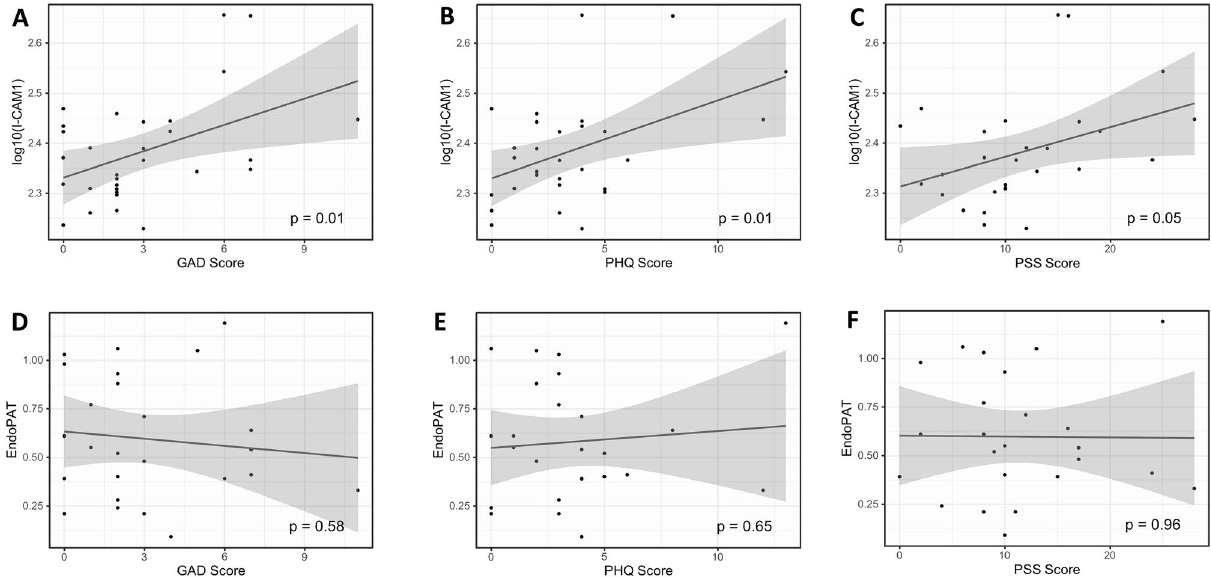
Figure 2. Correlation of endothelial dysfunction markers with psychosocial stress measures.